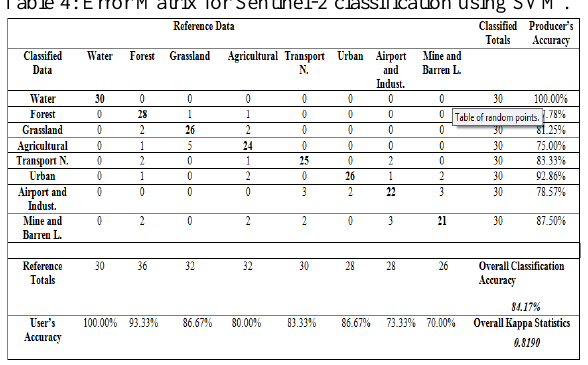
Table 4: Error Matrix for Sentinel-2 classification using